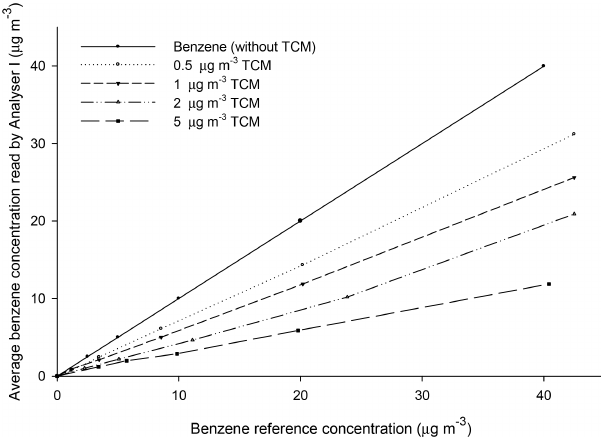
Figure 2. Calibration lines for Analyser I with and without TCM at different concentration levels.